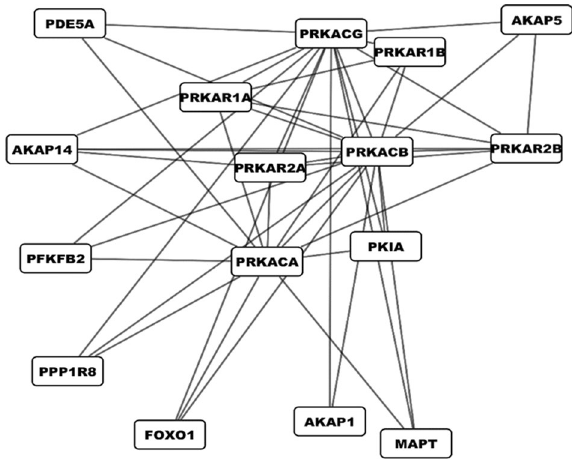
Figure 5. The interactive network reconstructed based on experimental evidence. The network consists of 16 nodes, including genes of the cAMP-dependent protein kinase subunits, as well as other structurally and functionally important genes such as MAPT, FOXO1, and PDE5A. The 16 genes interact with each other through 45